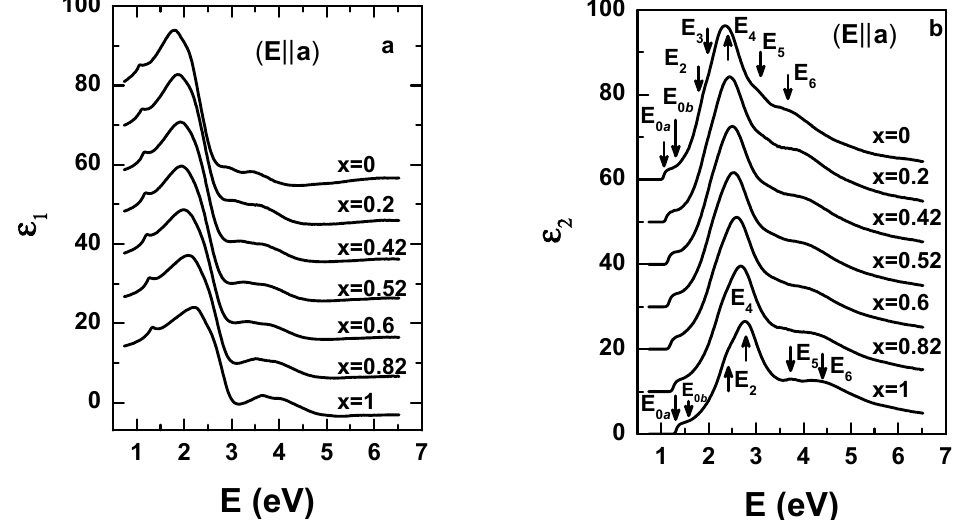
Figure 6. Real ( a ) and imaginary ( b ) parts of the dielectric functions of SnS x Se 1- x along the zigzag direction. The spectra are shifted by increments of 10 from that at x = 1.